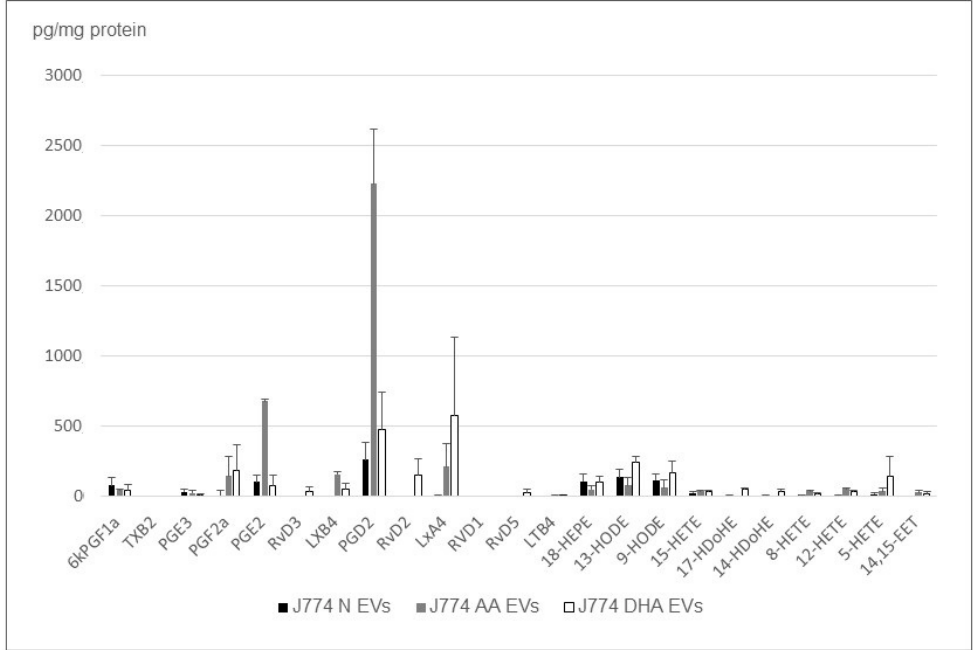
Figure 5. Lipid mediator profile from EVs obtained from deprived J774 cell cultured in triplicate without long chain fatty acid supplementation (N), or supplemented, respectively, with 10 µ M of arachidonic acid (AA), eicosapentaenoic acid (EPA) or docosahexaenoic acid (DHA).